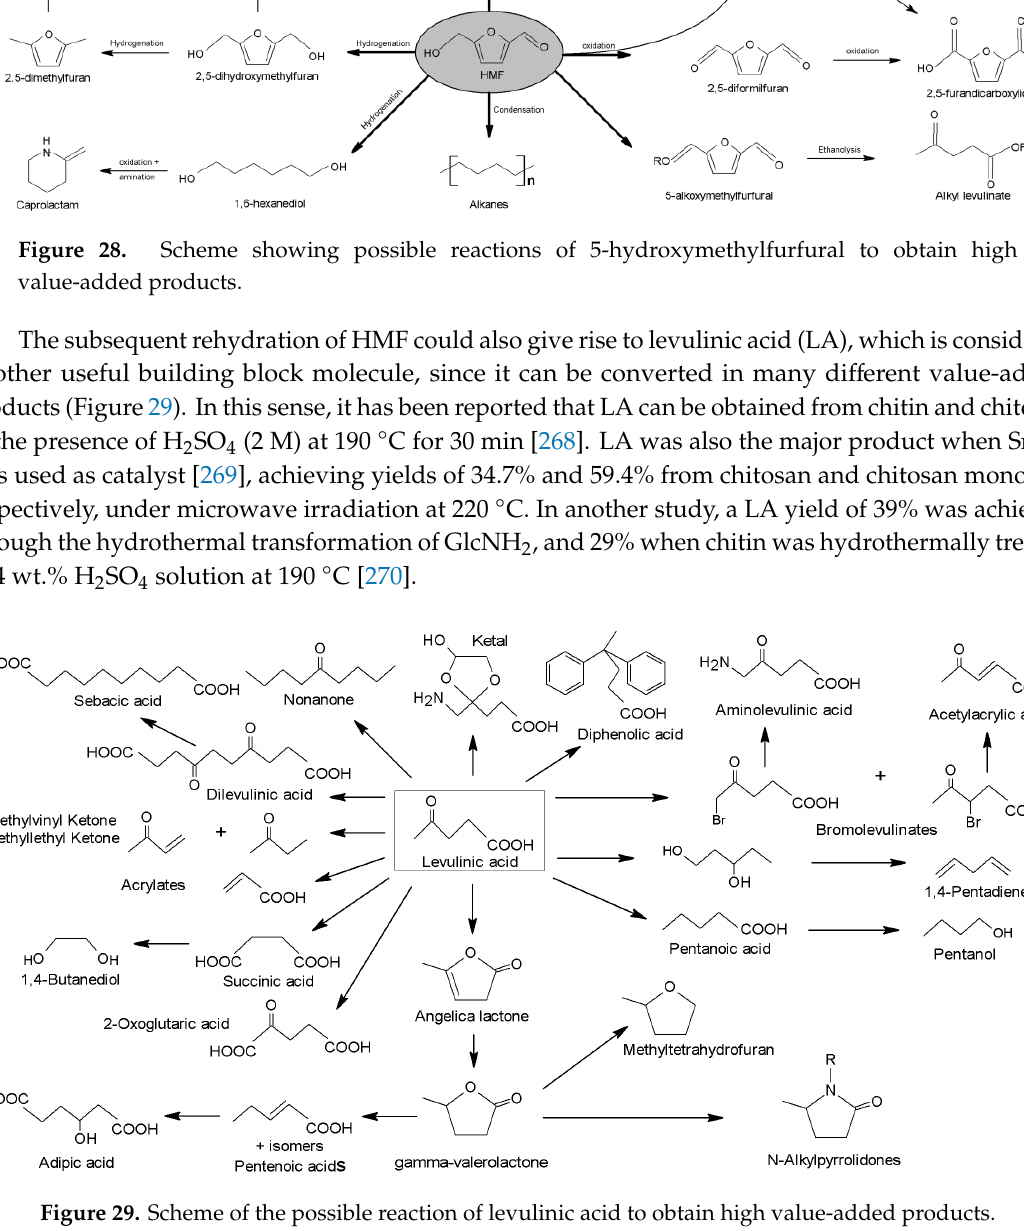
Figure 29. Scheme of the possible reaction of levulinic acid to obtain high value-added products.